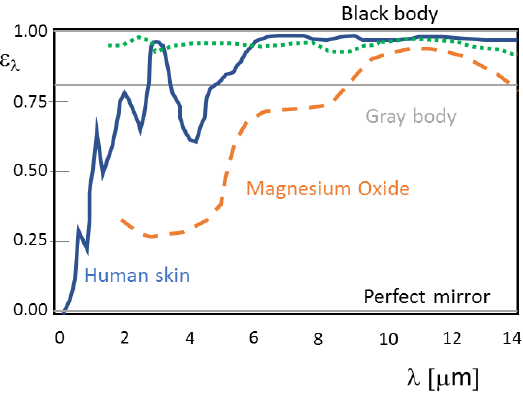
Figure 5. Monochromatic emissivity trend of human skin and other surfaces.